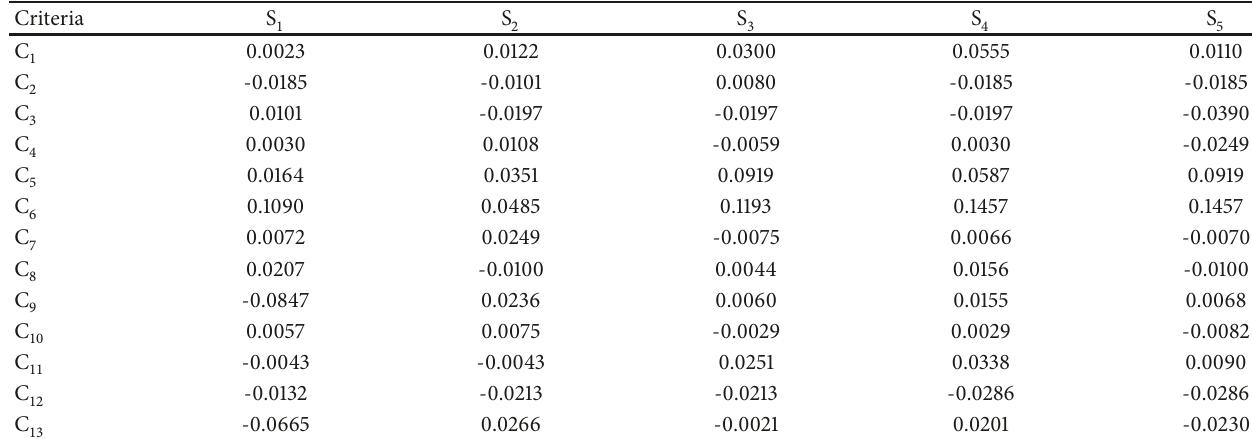
Figure 4: Ranking of energy sources using the different methods. Table 14: Weighted information contents of the criteria with respect to the maintenance systems.